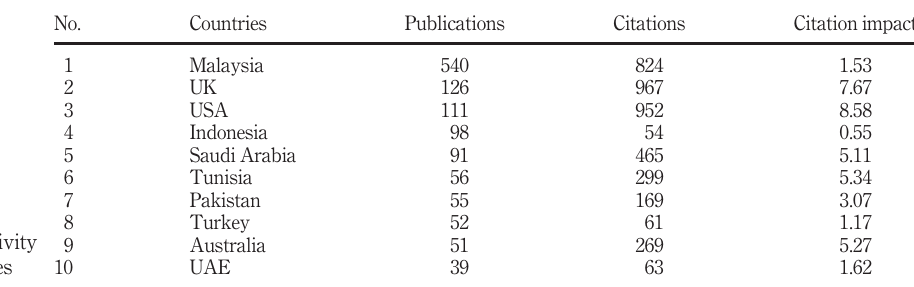
Islamic fi nance research productivity of top-10 countries